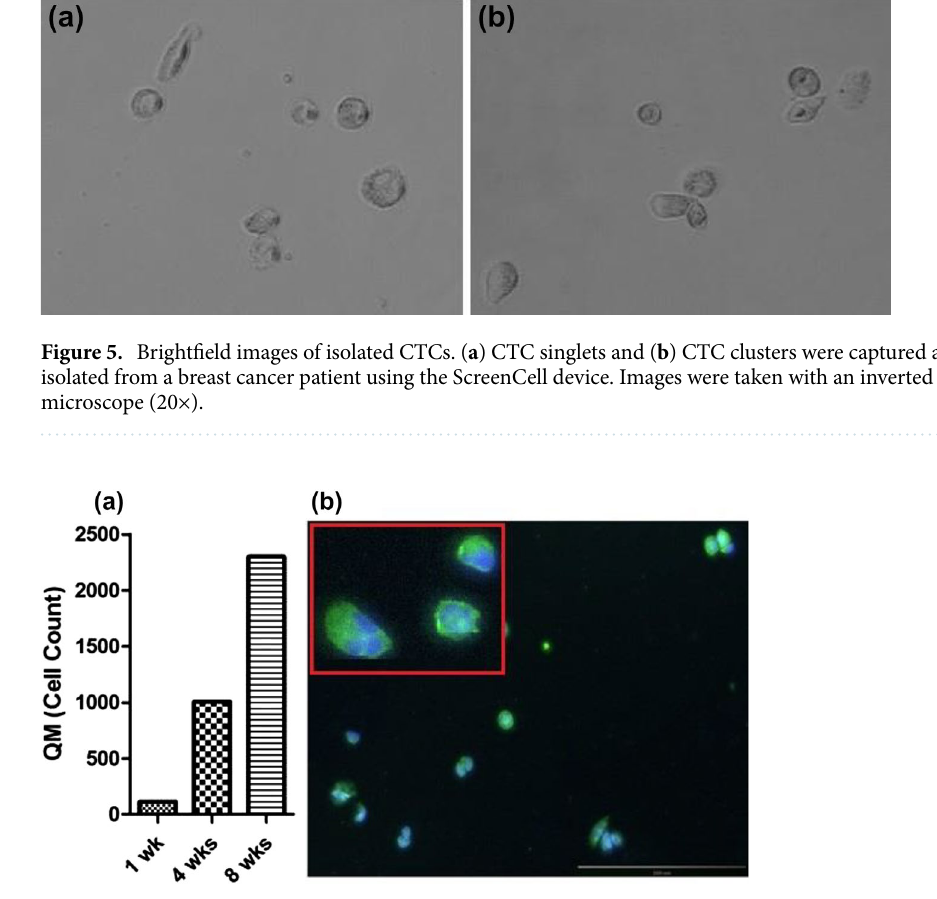
Figure 6. Quasi-mesenchymal (QM) cells derived from a breast cancer patient blood sample. ( a ) The figure illustrates the number of QM cells cultured over time (1wk, 4 wks and 8 wks) as measured using a haemocytomer. ( b ) Immunostaining revealed that these cells express HER2 at 8 weeks. Cells were counterstained with Hoechst 33342, blue for visualisation of cell nuclei. Imaging was performed using an inverted microscope